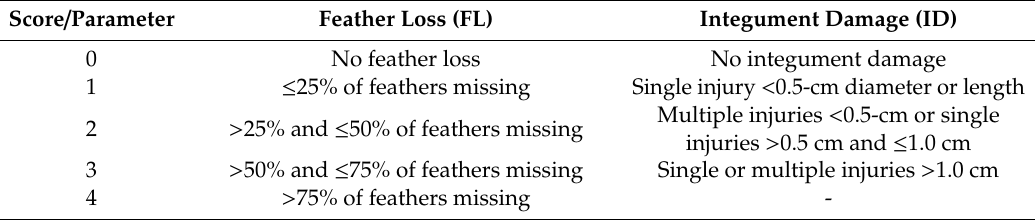
Table 1. Scoring scheme for the condition of plumage and integument (Giersberg et al., 2017). Score /